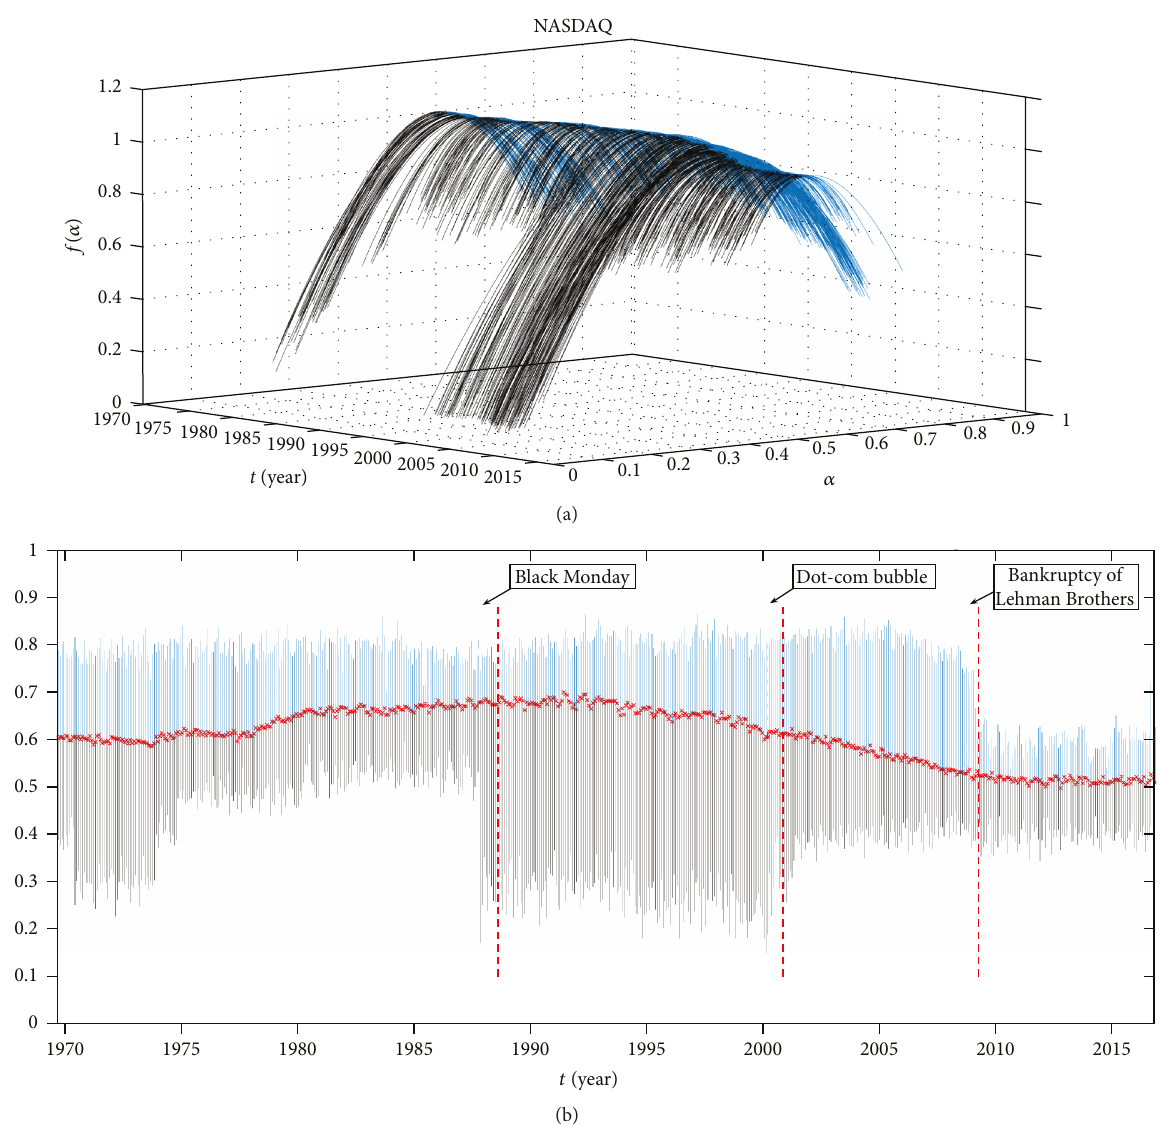
Figure 3: The same as in Figure 2, but analysis is carried out for the NASDAQ